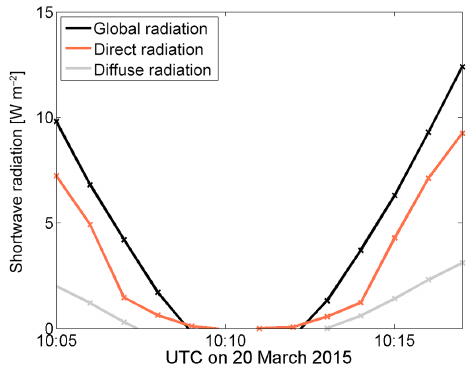
Figure 6. The downward shortwave radiation components’ direct, diffuse, and global radiation during the total eclipse phase.